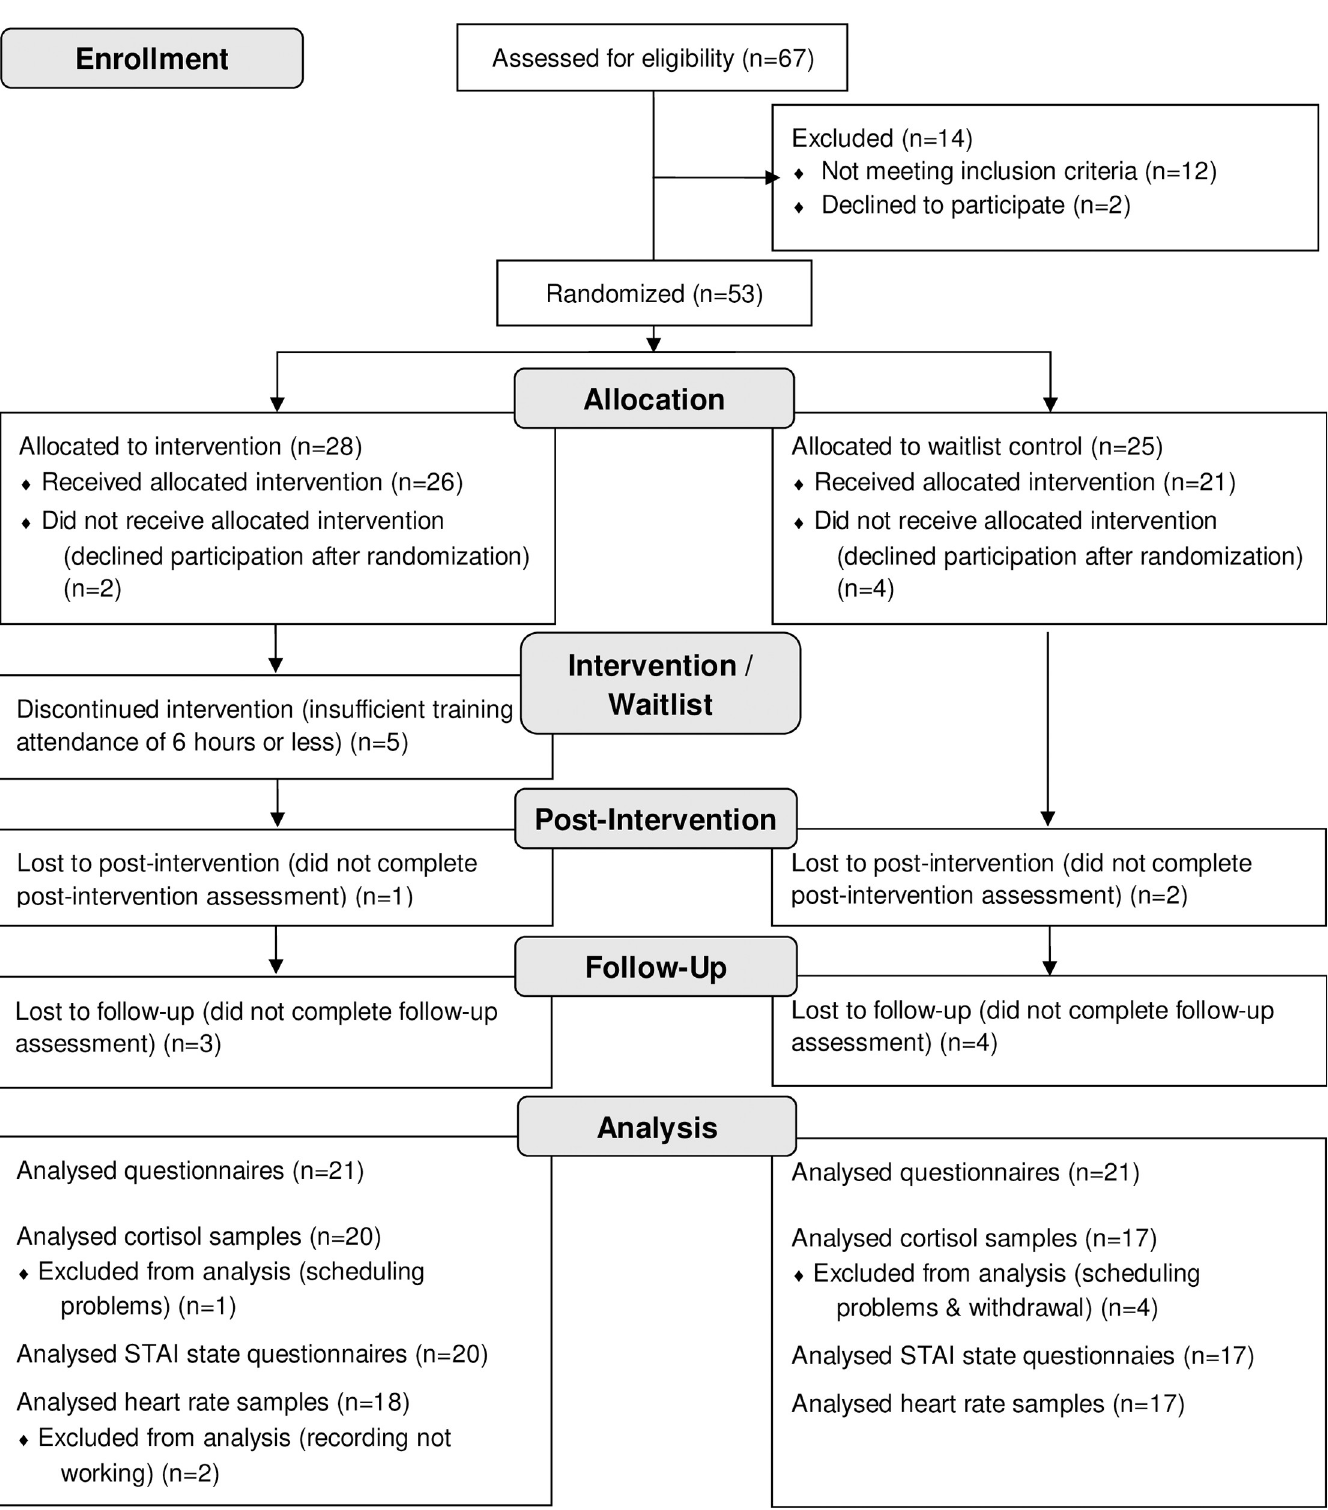
PLOS ONE | https://doi.org/10.1371/journal.pone.0252568 June 4,